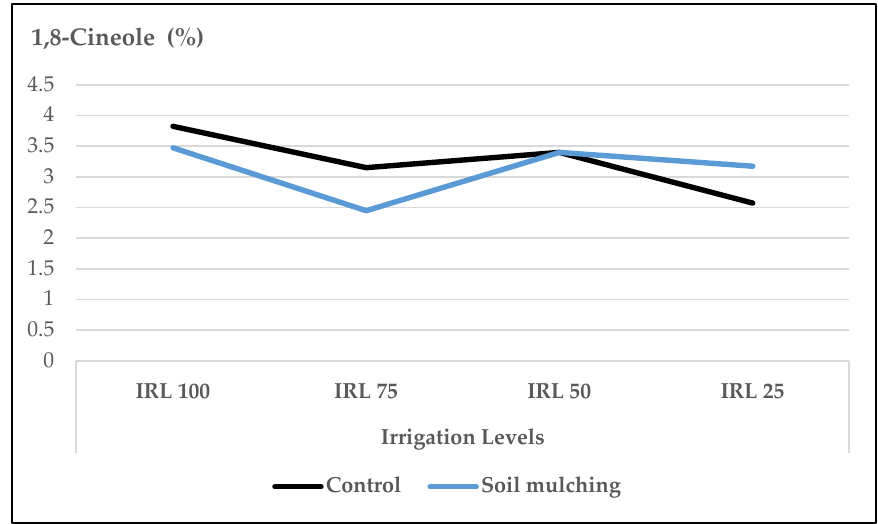
Figure 10. Mean values of 1,8-cineole at different IRLs of O. basilicum L. essential oil under soil mulching and control conditions; IRL 100 = 100% FC; IRL 75 = 75% FC; IRL 50 = 50% FC; IRL 25 = 25%.